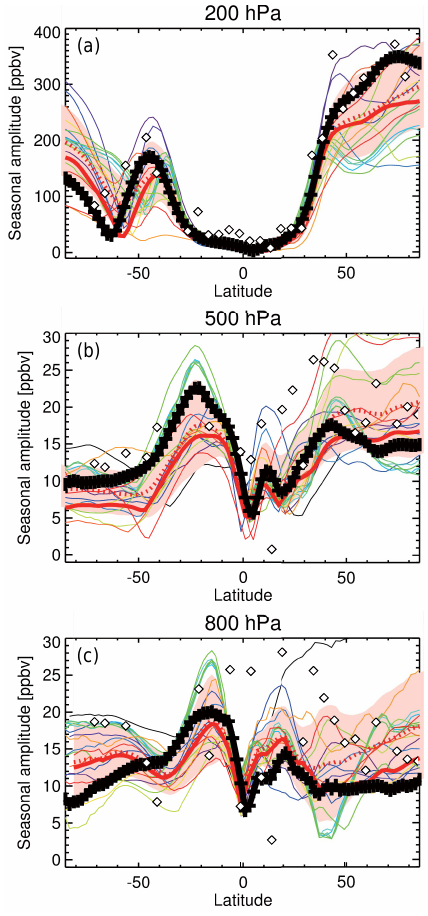
Figure 6. Seasonal amplitude (peak-to-peak difference based on monthly data) estimated from the reanalysis (black solid line) and ACCMIP models (thin colored lines). The ± 1 σ deviation among ACCMIP models (i.e., model spread) is shown in pink. The seasonal amplitude derived from the multi-model mean fields (red solid line), the multi-model mean of the seasonal amplitude from each model (red dashed line), and ozonesonde observations with a bin of 5 de- grees (black diamonds) are also shown. From top to bottom, results are shown for 200, 500, and